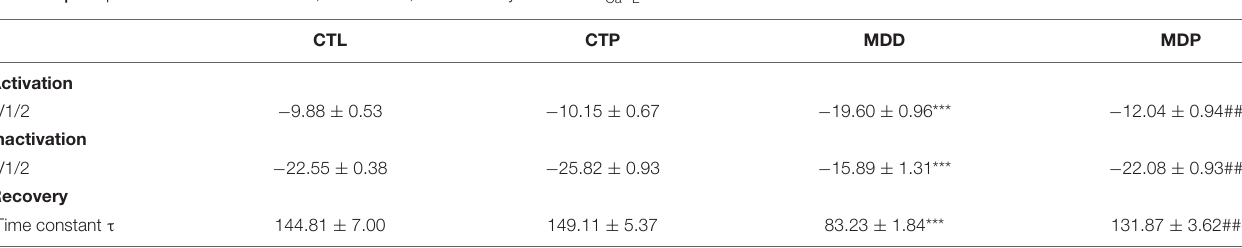
FIGURE 7 | Electrophysiological characteristics of I Ca − L . (A) Typical I Ca − L current traces. (B) The voltage-dependent current density (the I-V curve) and maximum current density of I Ca − L . (C) The voltage-dependent activation curve and the steady-state inactivation curve fitted to the Boltzmann distribution. (D) The recovery curve fitted to the monoexponential function. n = 6 per group. * p < 0.05 vs. CTL; # p < 0.05 vs. MDD. TABLE 2 | The parameters of the activation, inactivation, and recovery kinetics of I Ca − L